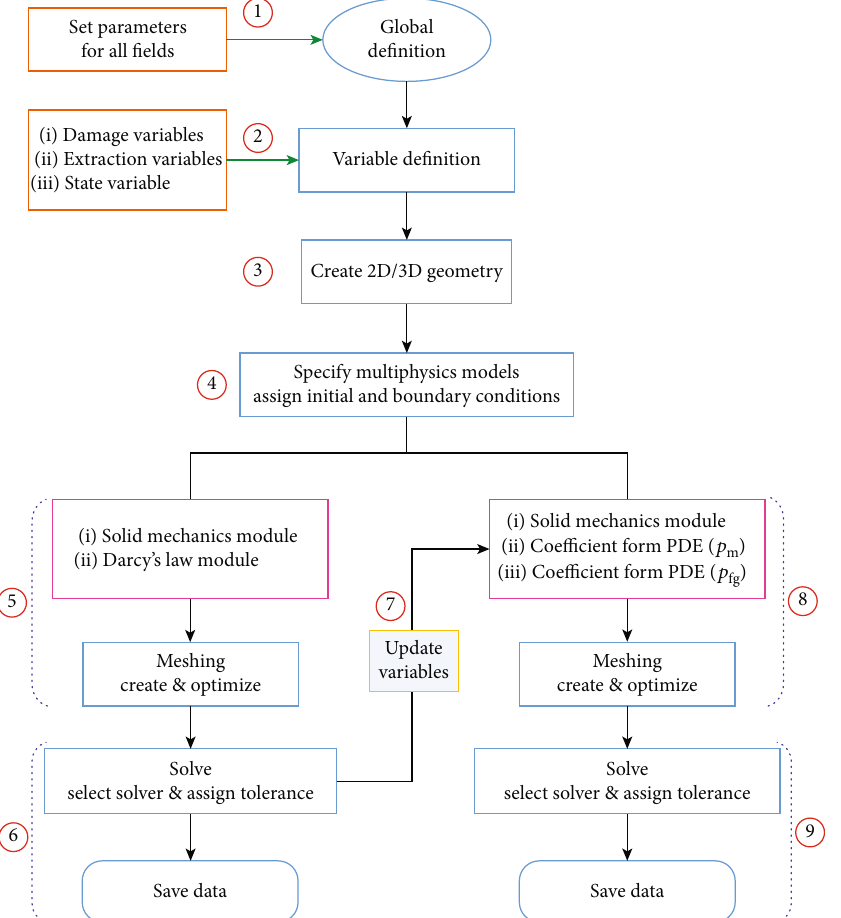
Figure 3: COMSOL implementation of coalbed methane extraction after hydraulic